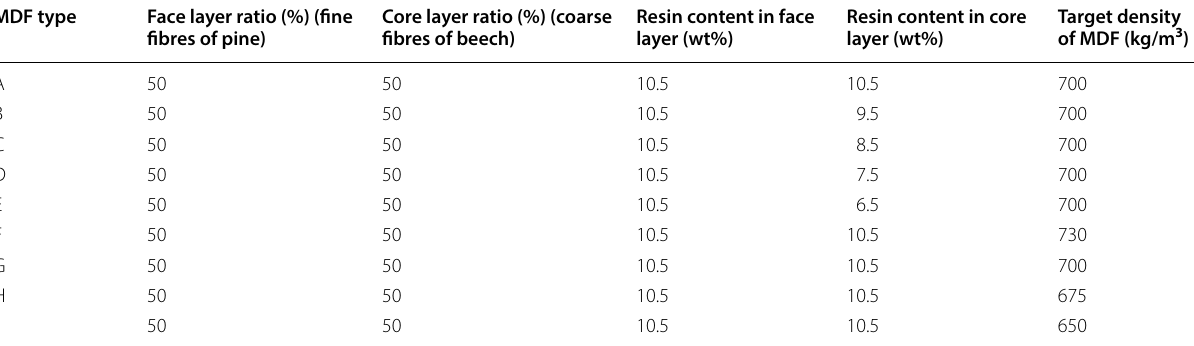
Table 1 Experimental